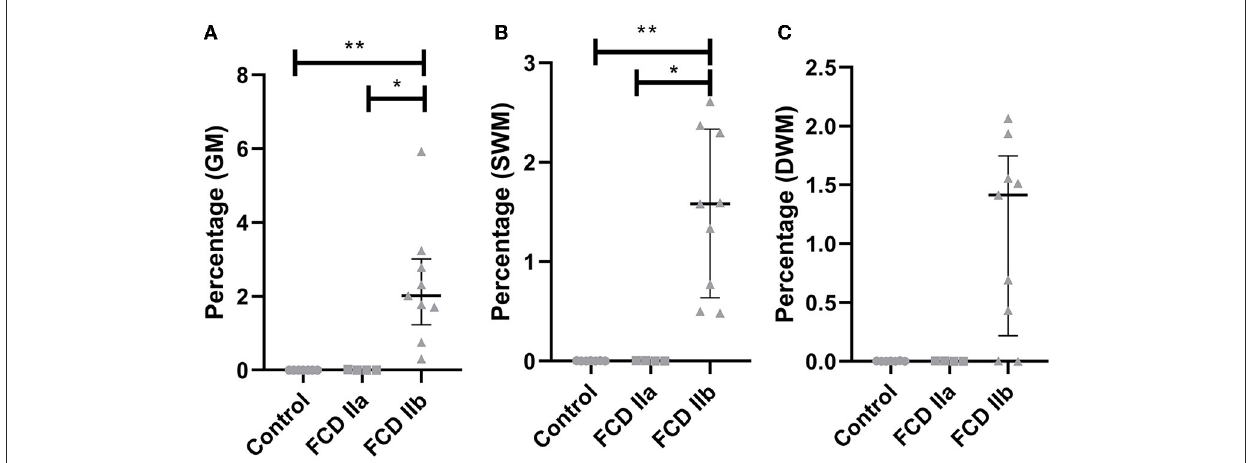
FIGURE9 Quantification of the immunohistochemical expression (percentage of positive pixels per total number of pixels) of GPNMB in the gray matter [GM; (A) ], superficial white matter [SWM; (B) ] and deep white matter [DWM; (C) ] of focal cortical dysplasia and controls. The graphs show scatterplots with superimposed median and interquartile range (25–75). * p < 0.05; ** p < 0.01 (Kruskall-Wallis test followed by Dunn’s post-hoc